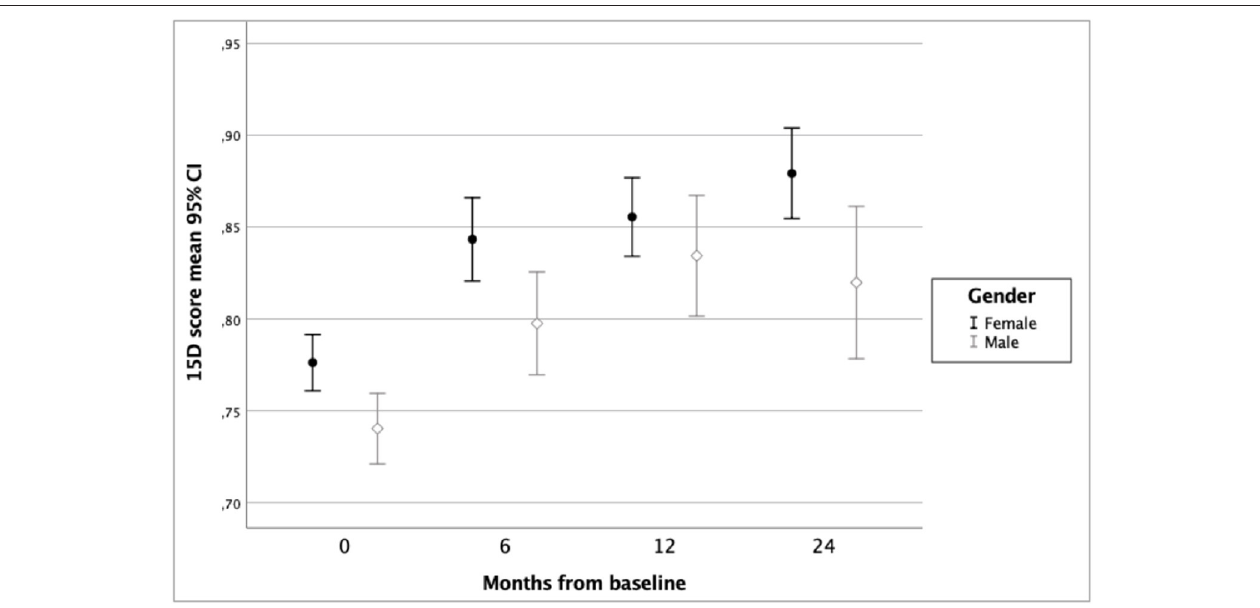
FIGURE 1 | Health-related quality of life of ODS study patients according to 15D score and gender.